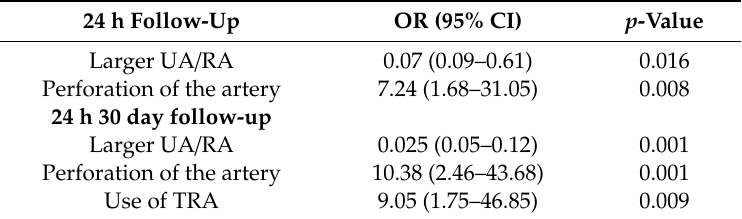
Table 7. Independent factors for RAO/UAO at 24 h and 30 day follow-ups based on logistic regression calculation.